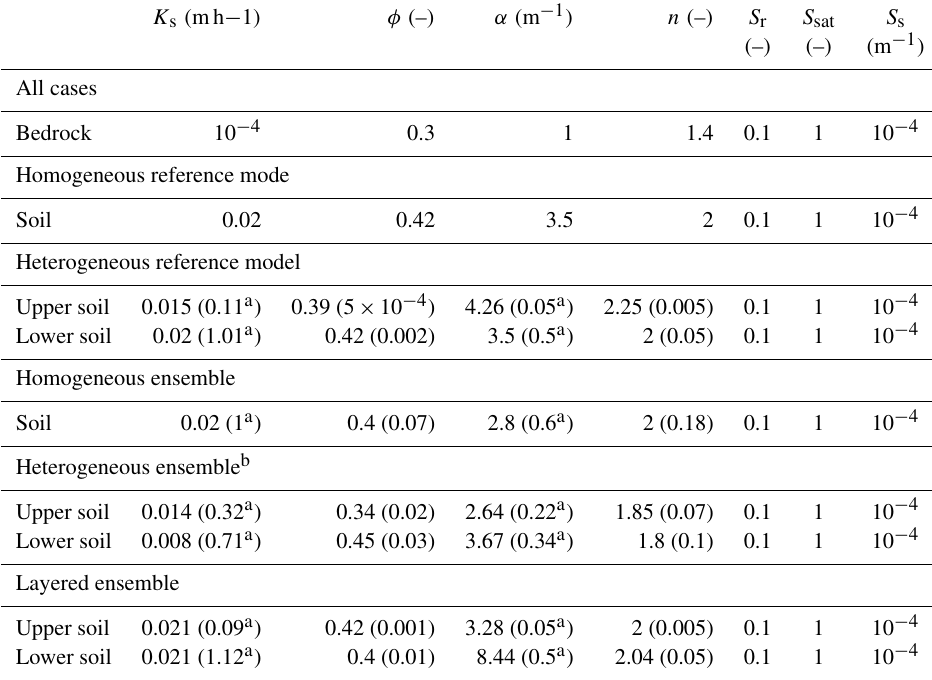
Table 1. Values of the soil hydraulic parameters for the different models. The values in parentheses are the standard deviations of the parameter distributions.